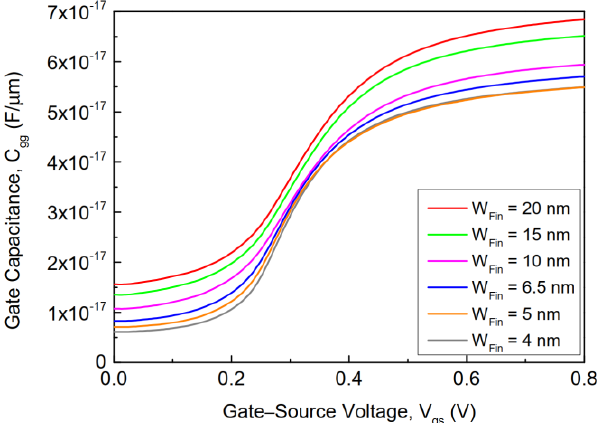
Figure 5. Gate capacitance as a function of gate – source voltage with different values of the fin width at V ds = 0.05 V. The fin height is kept fixed at 26 nm.